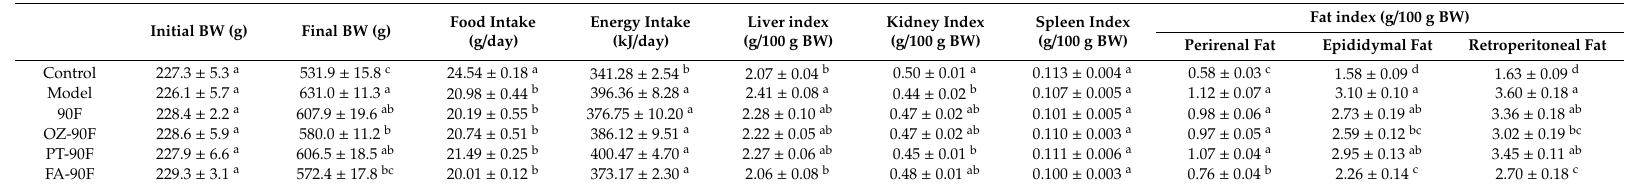
Table 2. E ff ect of enriched flour on body weight, food intake, energy intake, and organ indices in HFFD-fed